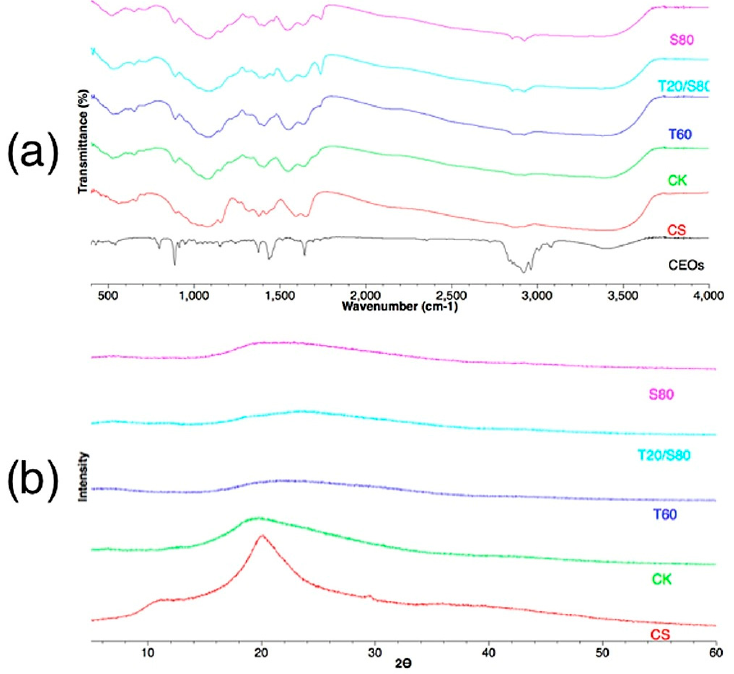
Figure 24. ( a ) FTIR spectroscopy, ( b ) X ‐ ray diffraction of pure chitosan (CS), control group (CK), Tween 60, Tween 20/Span 80, and Span 80 [208]. Tween 60, Tween 20/Span 80, and Span 80